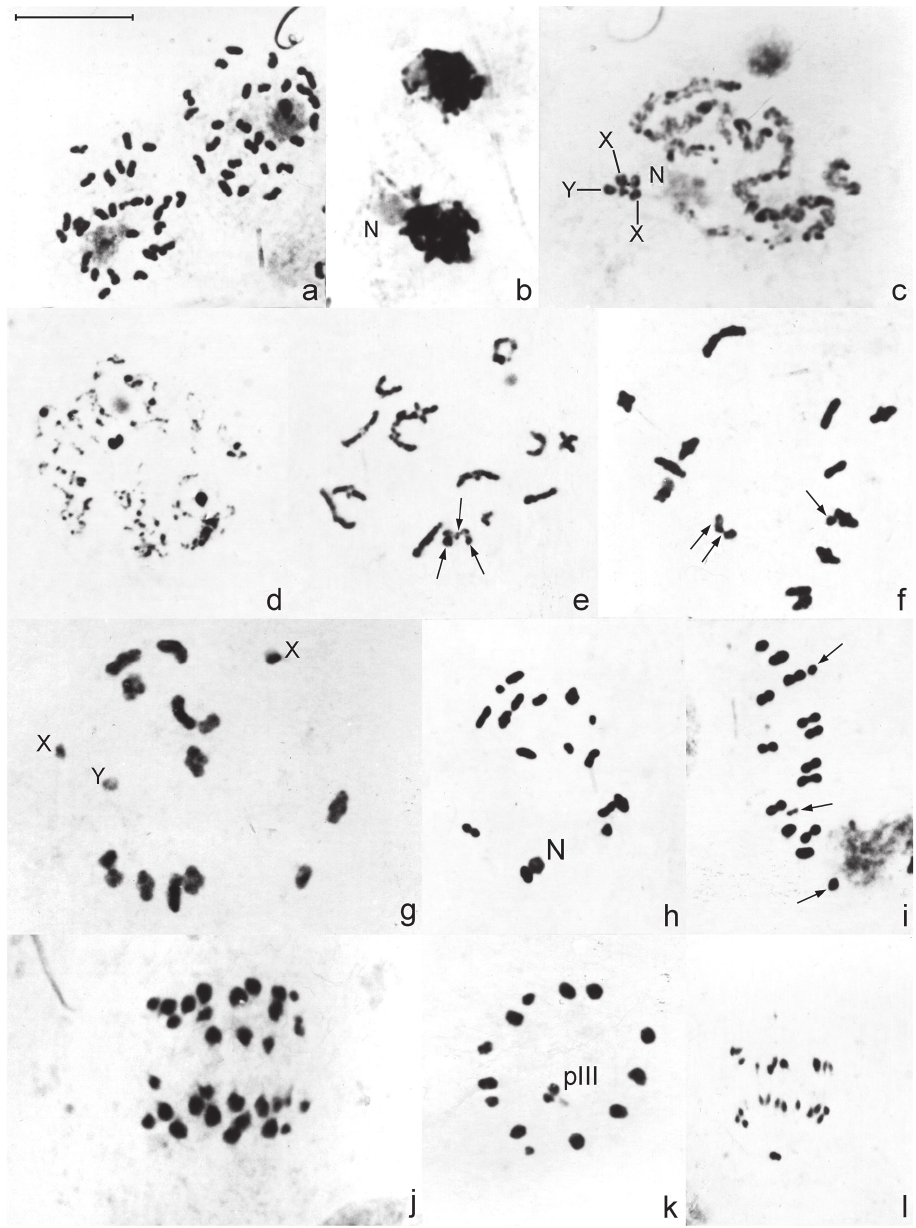
Figure 2. Male meiosis in B. elongatum ( b, c, g, j, k ) and B. gestroi ( a, d, e, f, h, i, l ) stained with 2% iron-propionic haematoxylin. a Spermatogonial prometaphase b Synizesis c Pachytene, X and Y = sex chromosomes d Diffuse stage e–f Early diakinesis g–h Diakinesis i Metaphase I j Anaphase I k Meta- phase II, Y sex chromosome is negatively heteropycnotic l Anaphase II. Arrows indicate sex chromosomes. pIII = pseudo-trivalent. N = nucleolus. Bar = 10